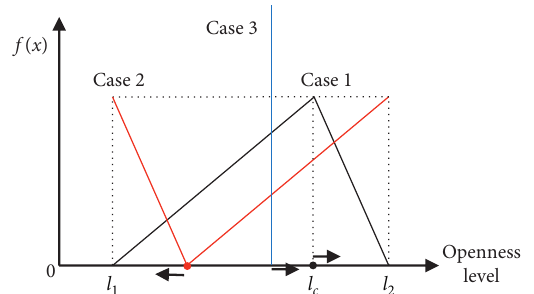
Figure 3: Probability density function of three